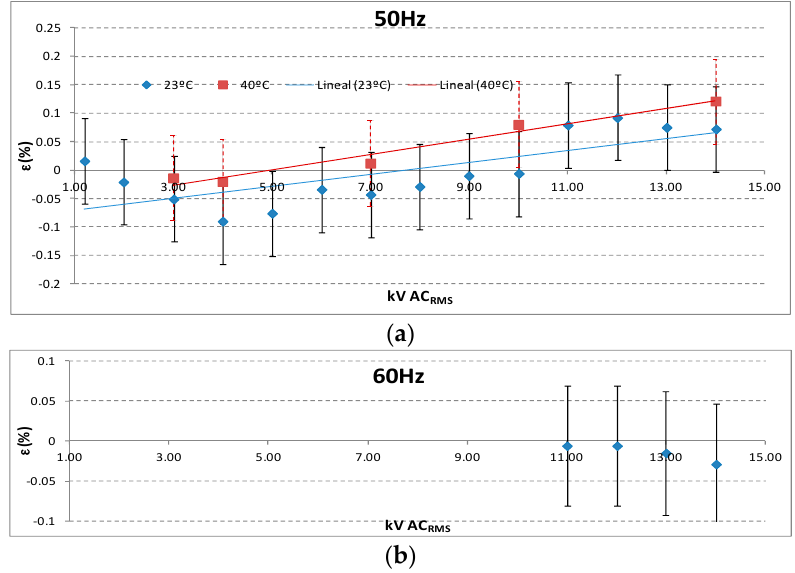
Figure 11. ( a ) Ratio errors for HV calibration from 1 to 14 kV, 50 Hz at 20 °C and 40 °C, ( b ) ratio errors for HV calibration from 11 to 14 kV, 60 Hz at 20 °C.